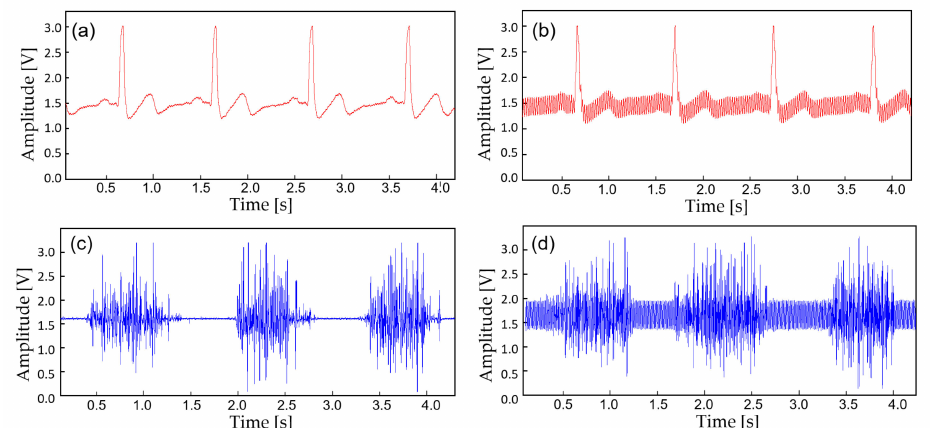
Figure 6. A noise comparison with the captured biopotential signals. ( a ) ECG acquired outdoors; ( b ) ECG at 30 cm away from the wall power; ( c ) EMG acquired outdoors; ( d ) EMG at 30 cm away from the wall power.